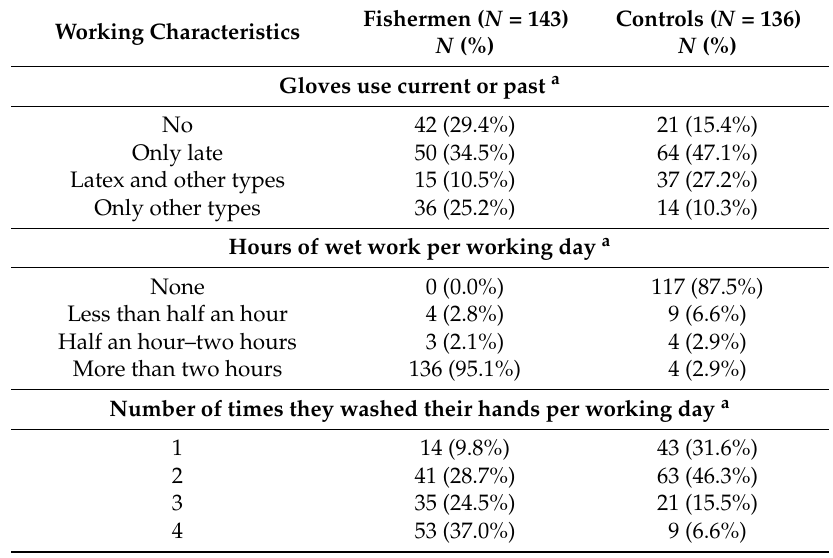
Table 2. Some characteristics of the working activities in the fishermen and